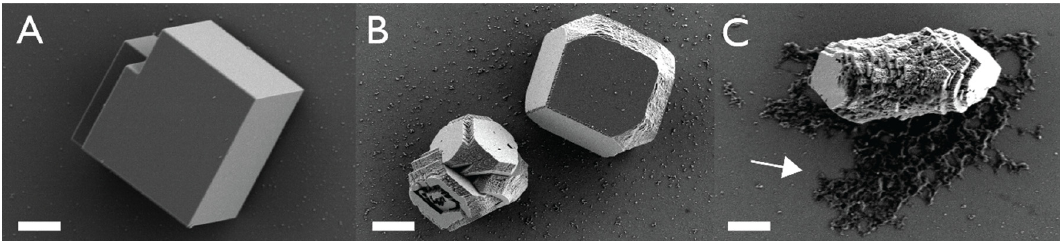
Figure 1. SEM images of in vitro calcium carbonate mineralization assay samples, following the protocol described in [27]. ( A ) Negative control, no protein added; ( B ) + rSpSM30B/C, non-glycosylated, 1.5 µM; ( C ) + rSpSM30B/C-G, glycosylated, 1.5 µM. Note faceted nanotexturing produced by both proteins, which is more pronounced in the presence of the glycosylated variant in ( C ). White arrow in ( C ) denotes protein hydrogel deposit that forms within the mineralization assay. Scalebars = 2 µm.